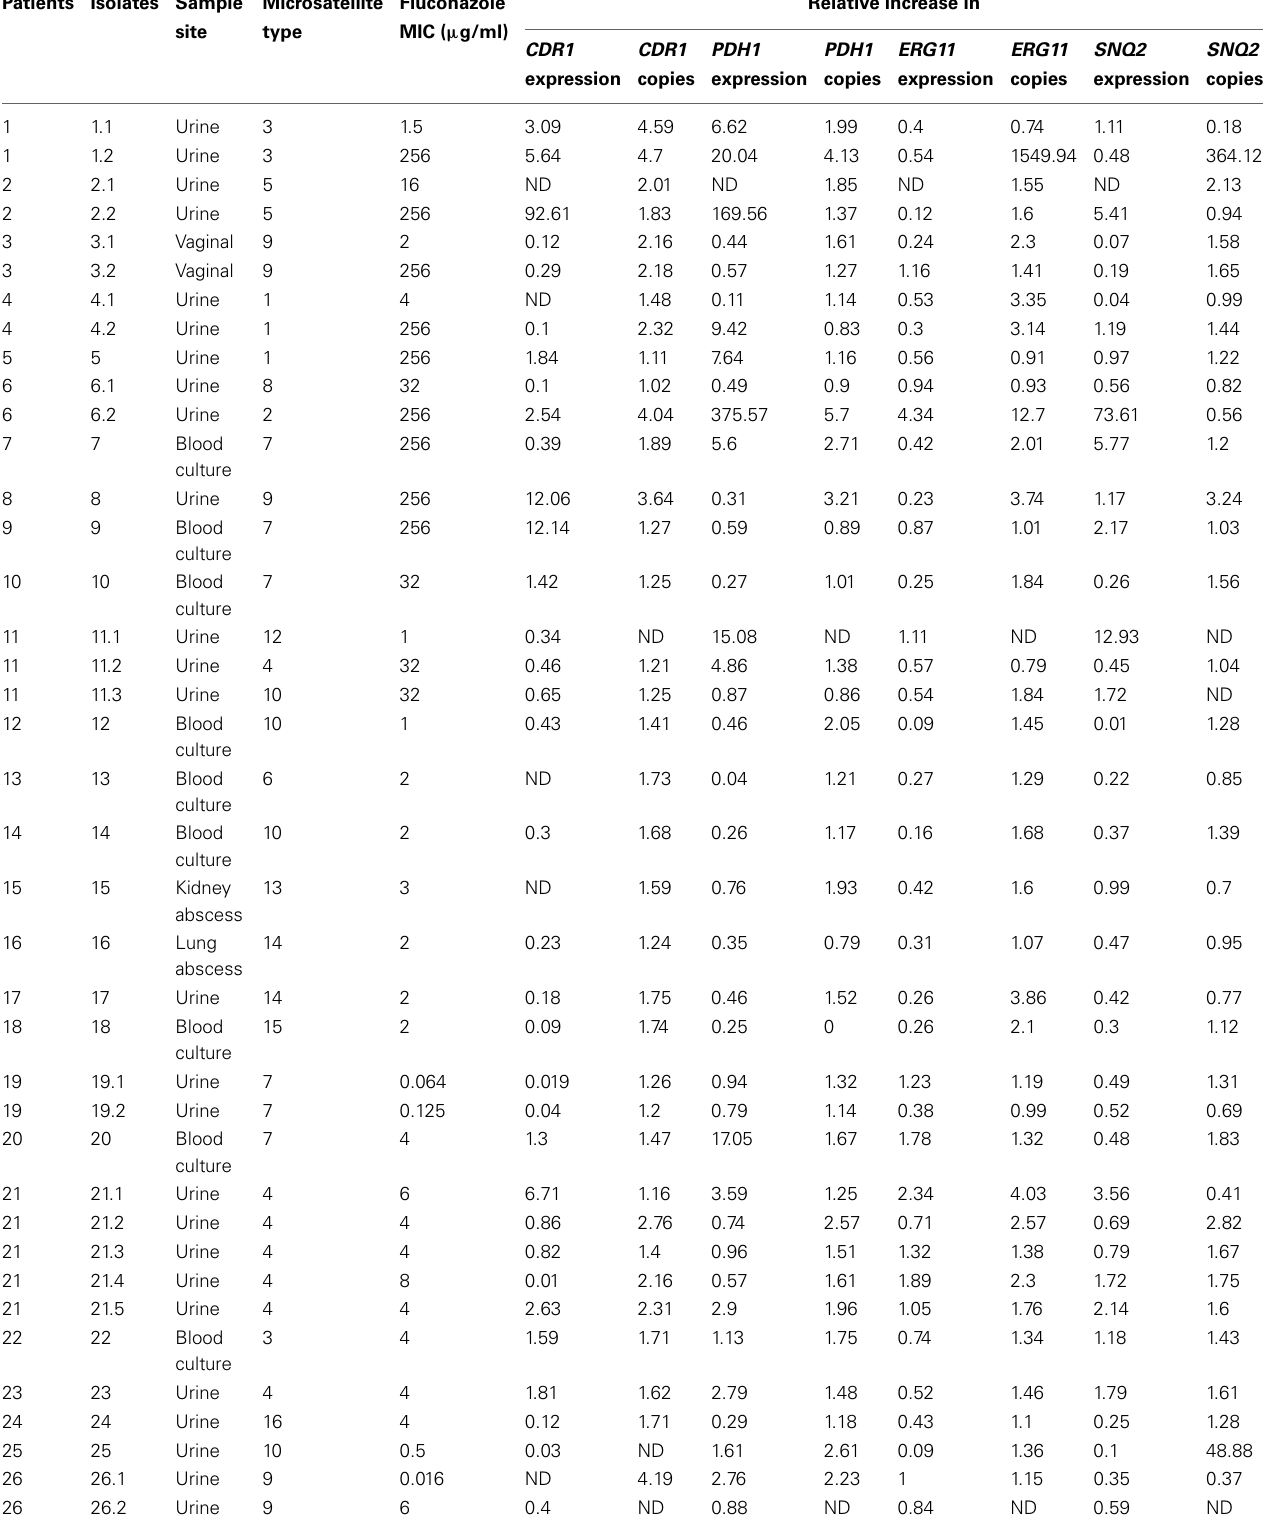
Table 2 | Relative gene expression levels and copy numbers of CgCDR1 , CgPDH1 , CgERG11 , and CgSNQ2 in fluconazole sensitive and resistant Candida glabrata